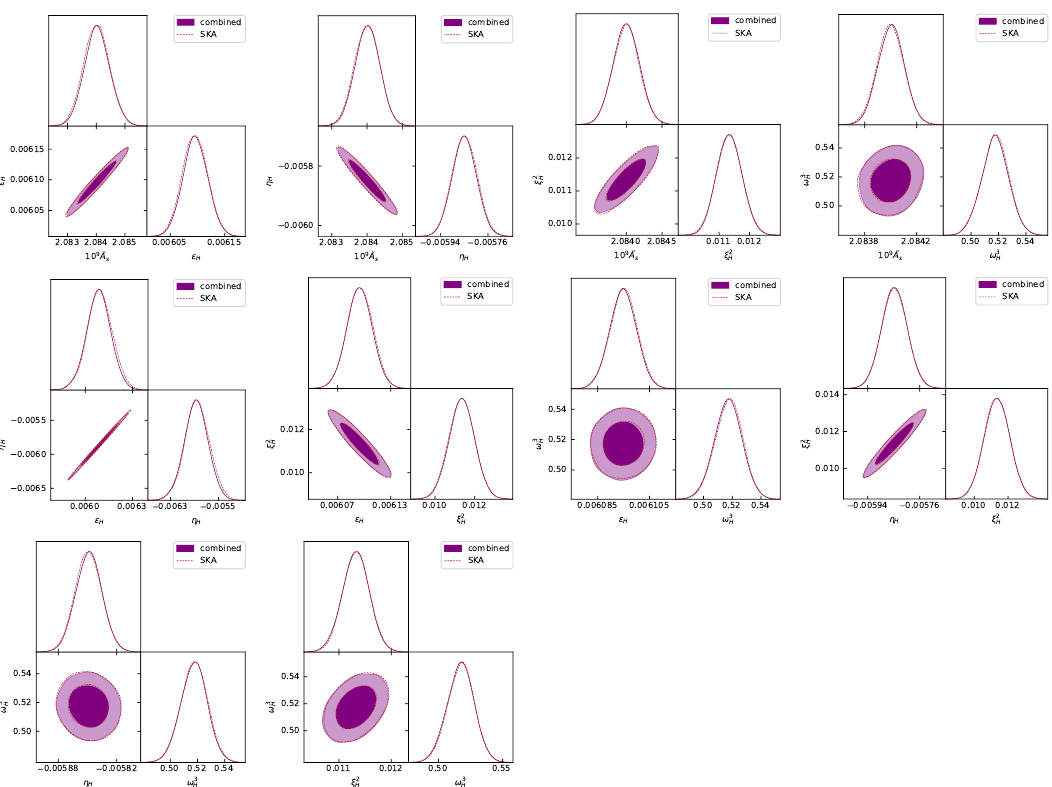
Figure 8: Sliced 2-dimensional likelihoods for the slow-roll parameters from a com- bination of Planck and SKA projections. We also show the SKA-only contours from Fig. 4 as red dashed lines, the results should be compared to the Planck results shown in Fig.